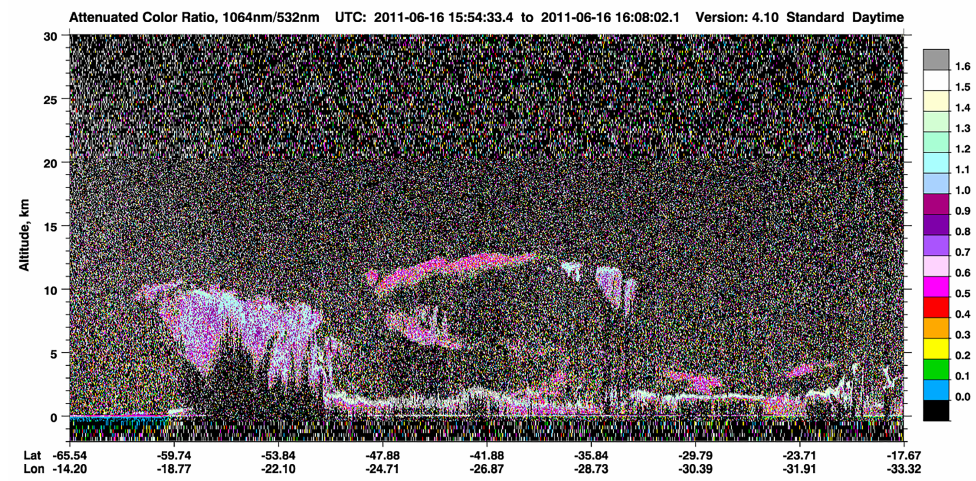
Figure 5. Image of CALIOP total attenuated colour ratio (1064 nm/532 nm) from 15:54–16:08 UTC on 16 June 2011 for the Puyehue–Cordón Caulle eruption [37].